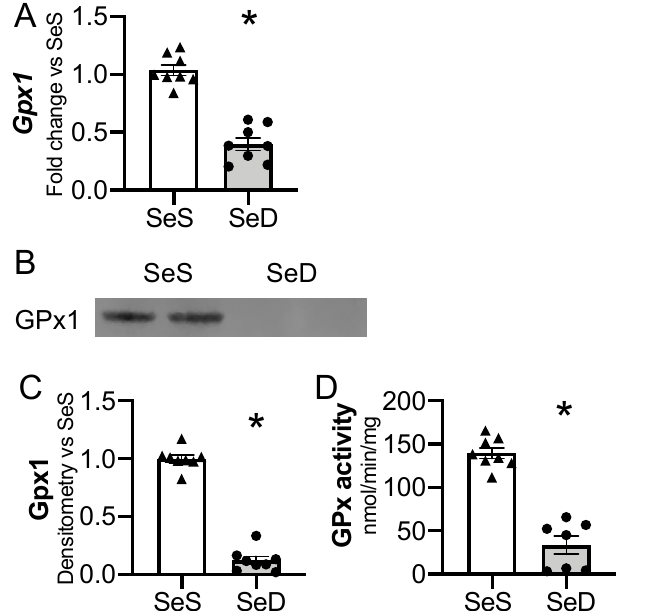
Figure 4. Neonatal hepatic glutathione peroxidase 1 is decreased by antenatal Se deficiency. C57Bl/6 mice were placed on diets that differed only in Se content, either 0.4 ppm or <0.01 ppm of sodium selenite. Breeding was initiated after 2–4 weeks on diet and natural delivery was allowed. Hepatic organ homogenate was evaluated on day of birth. Each data point represents either a female or male from each litter; each individual point is an average of two mice. ( A ) Fold change in Gpx1 mRNA expression is shown normalized to SeS samples. ( B ) Representative Western blot of hepatic Gpx1, Densitometric analysis of ( C ) Gpx1 protein content expression. Results are normalized to total protein stain and expressed as a ratio to Se sufficient mice. ( D ) Glutathione peroxide activity level by oxidation of NADPH per minute per milligram of protein. N = 7–8 for all groups. Data and presented as mean ( ± SEM), * p < 0.05 vs. SeS control, by two-sided t-test.